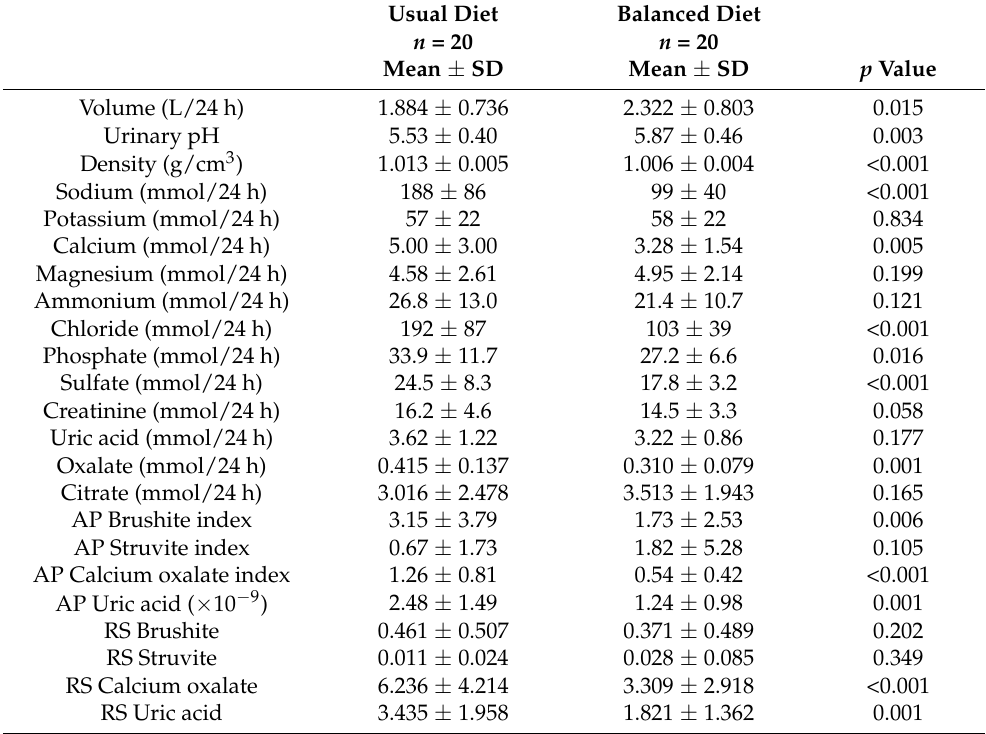
Table 2. Urinary parameters under the usual diet and balanced mixed